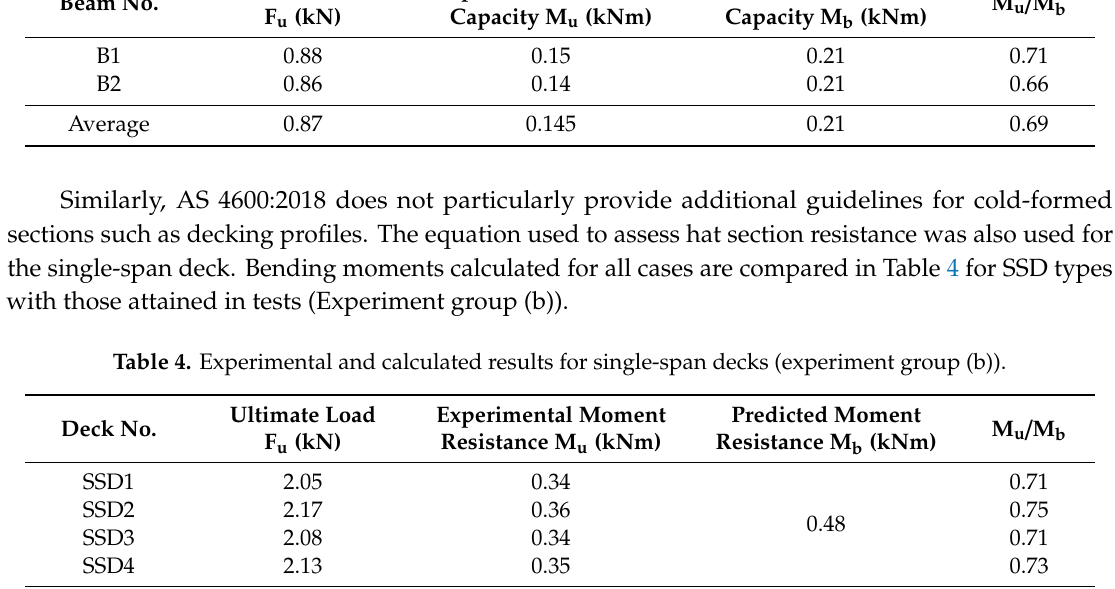
Table 3. Experimental and calculated results for individual top-hat sections (experiment group (a)). Beam No.